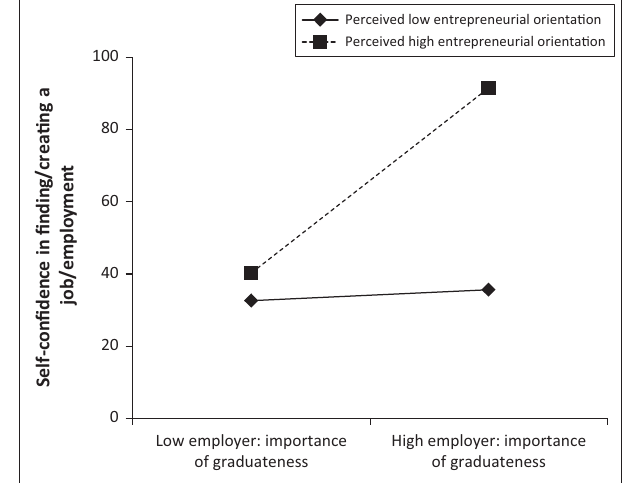
FIGURE 2: Interaction effects between perceived employer’s importance of graduateness and perceived entrepreneurial orientation in predicting self- confidence in finding or creating a job or employment.